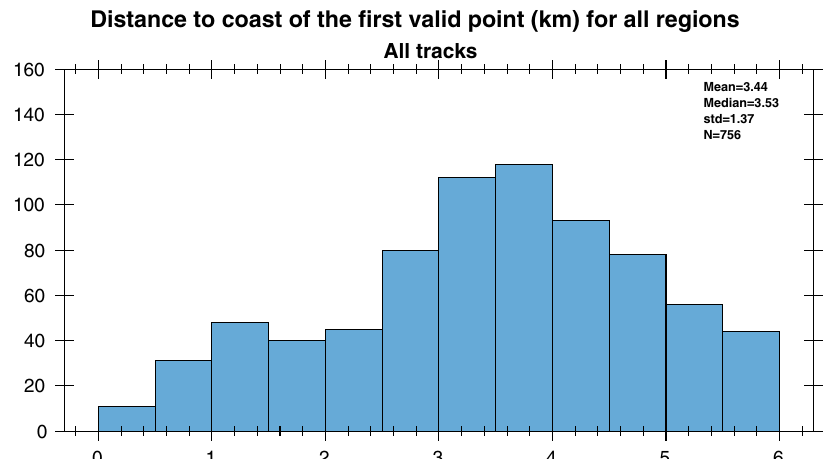
Fig. 3 Distribution of the distance to the coast of the 756 virtual stations. As shown by this histogram, the median value of the closest distance to the coast is about 3.5 km.